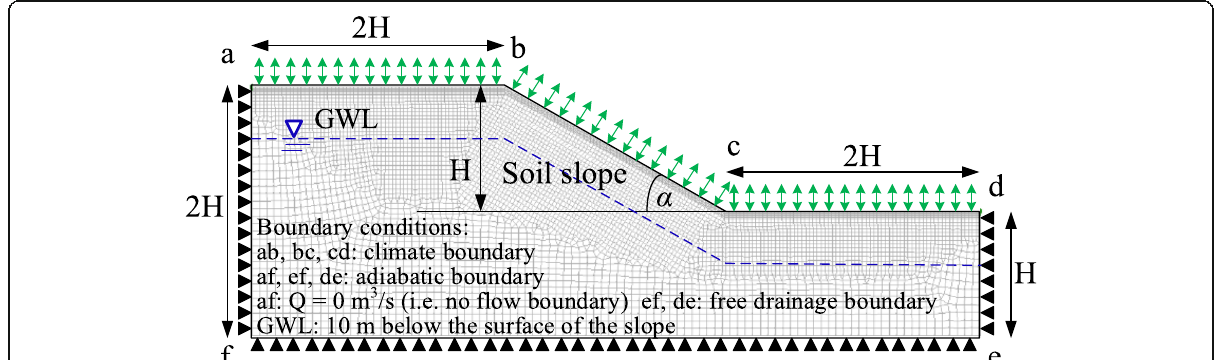
Fig. 5 2D numerical homogeneous slope model with applied boundary conditions